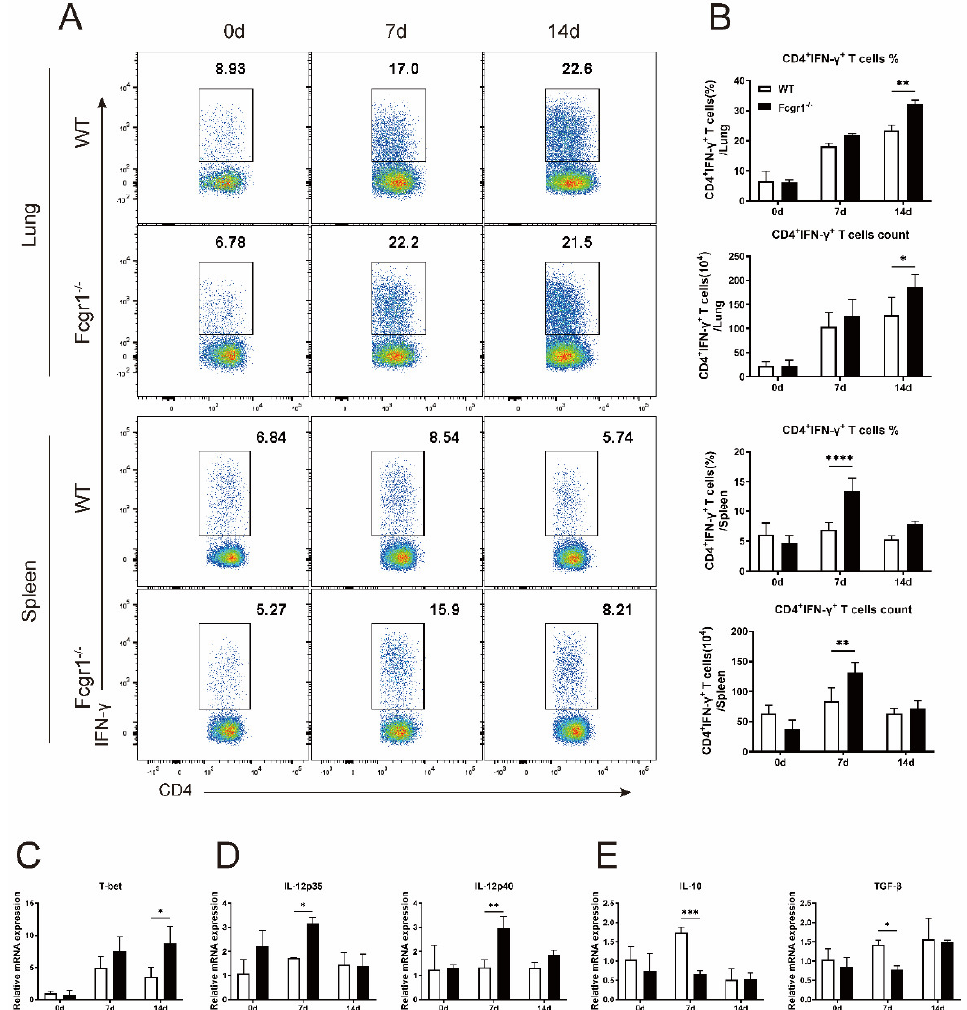
Figure 4. Increased Th1 response in Fcgr1 −/− mice after C. muridarum infection. ( A , B ) The lung and spleen single cells of WT and Fcgr1 −/− mice were prepared at days 0, 7, and 14 p.i., and the Th1 response was examined by flow cytometry. Representative flow cytometric plots of IFN-γ-producing CD4 + Th1 cells ( A ), summaries of their percentages and total numbers ( B ) are shown. ( C – E ) Total RNA extracted from the lung tissue was assayed for T−bet ( C ), IL−12p35/IL−12p40 ( D ), and IL−10/TGF−β ( E ) mRNA expression by qPCR. Data are represented as means ± SD from n = 3−5 per group, representative of one of three independent experiments. Statistical significances of differences are determined by two-way ANOVA. * p < 0.05, ** p < 0.01, *** p < 0.001, **** p < 0.0001.